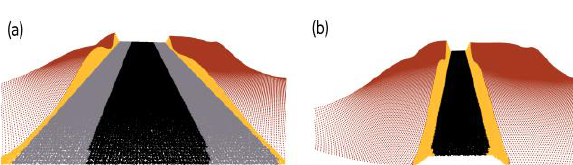
Figure 3. Simplified views of: (a) National road and (b) local road.